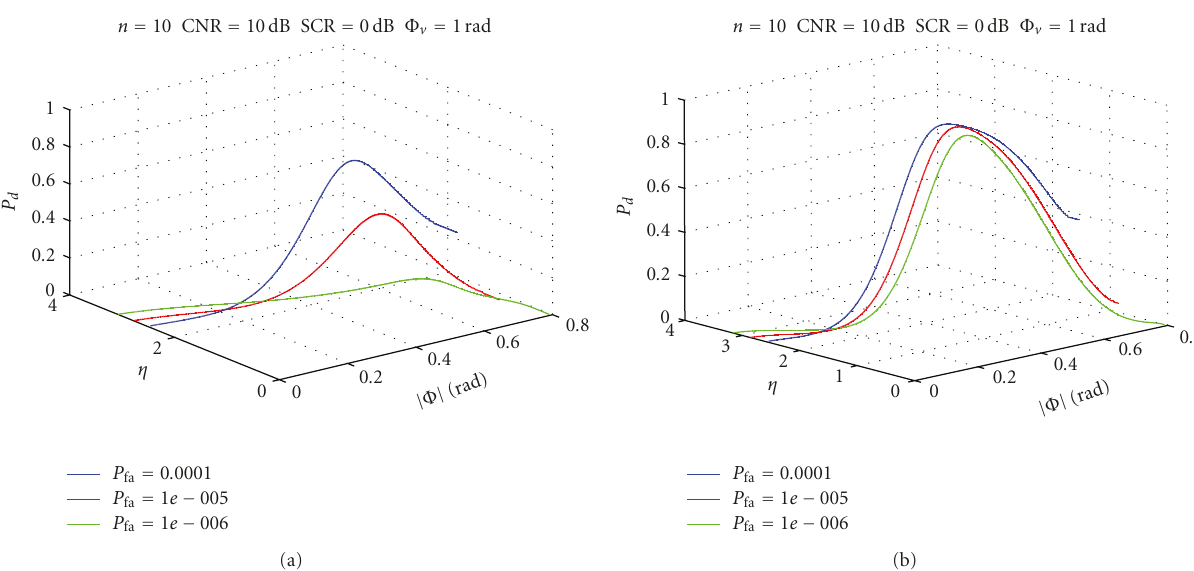
Figure 6: P d curves along iso- P fa curves with 3-D visualization for P fa = 1 e − 4, 1 e − 5, 1 e − 6, n = 10, CNR = 10 dB, SCR = 0dB, and Φ v = 1rad. (a) two-step CFAR detector with marginal PDFs; (b) Two-step CFAR detector with conditional PDF.